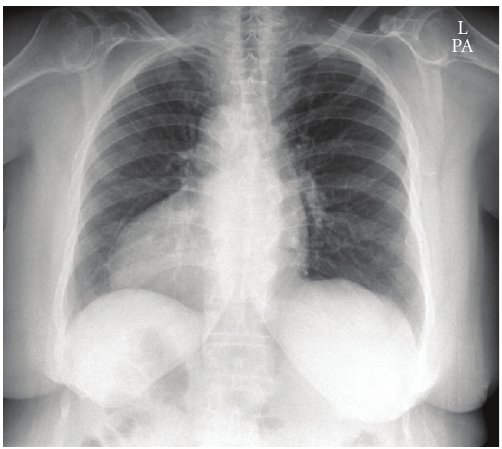
Figure 1: Chest radiograph confirming dextrocardia with right-sided aortic arch and right-sided gastric